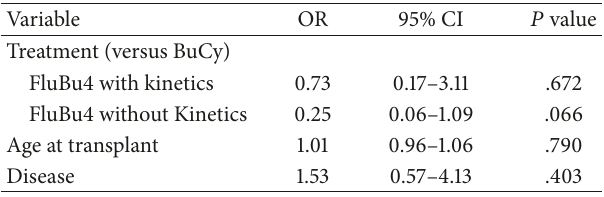
Table 5: Effect on the treatment group on being in the 100% chimerism on day 100 group versus being in the 86%–99% or < 86% chimerism on day 100, adjusting for age and disease type.